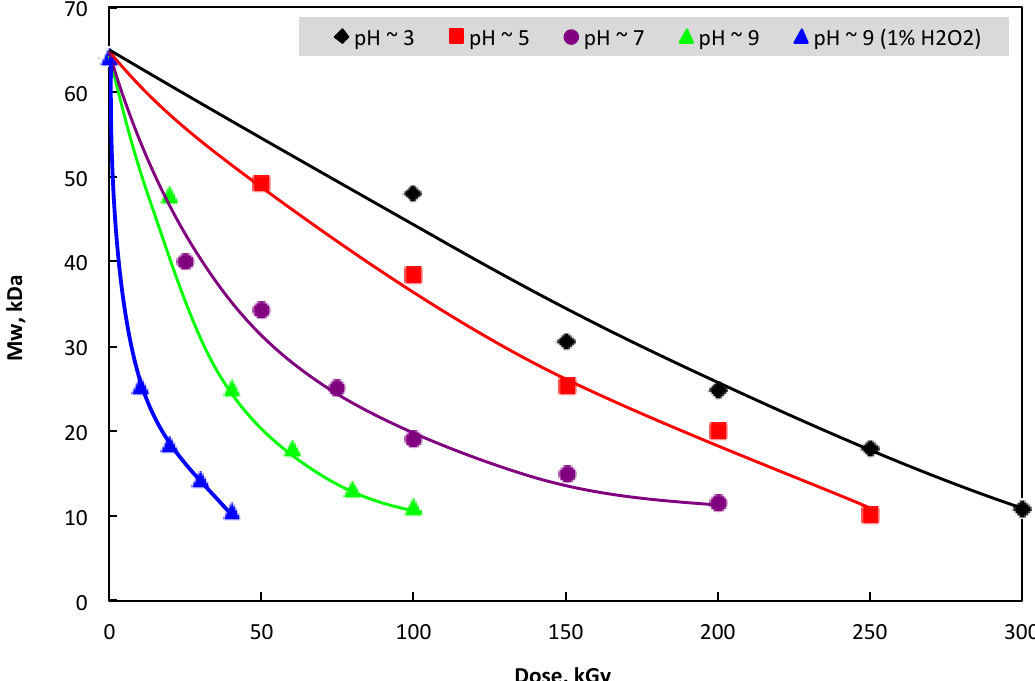
Figure 2. Change in molecular weight (Mw) of β -glucan by gamma irradiation at various conditions.